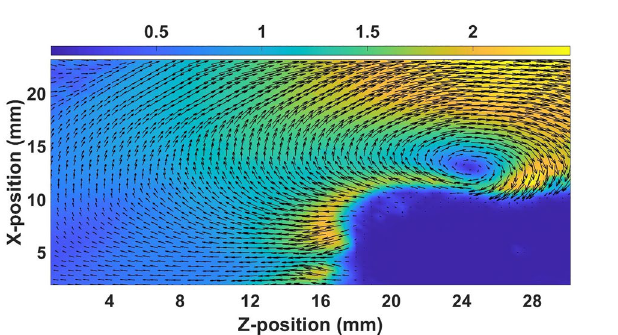
Figure 7. The velocity vector field with the magnitude of the velocity (cm/s) for the double layer flow at the input pressure of the pulse valve is 300